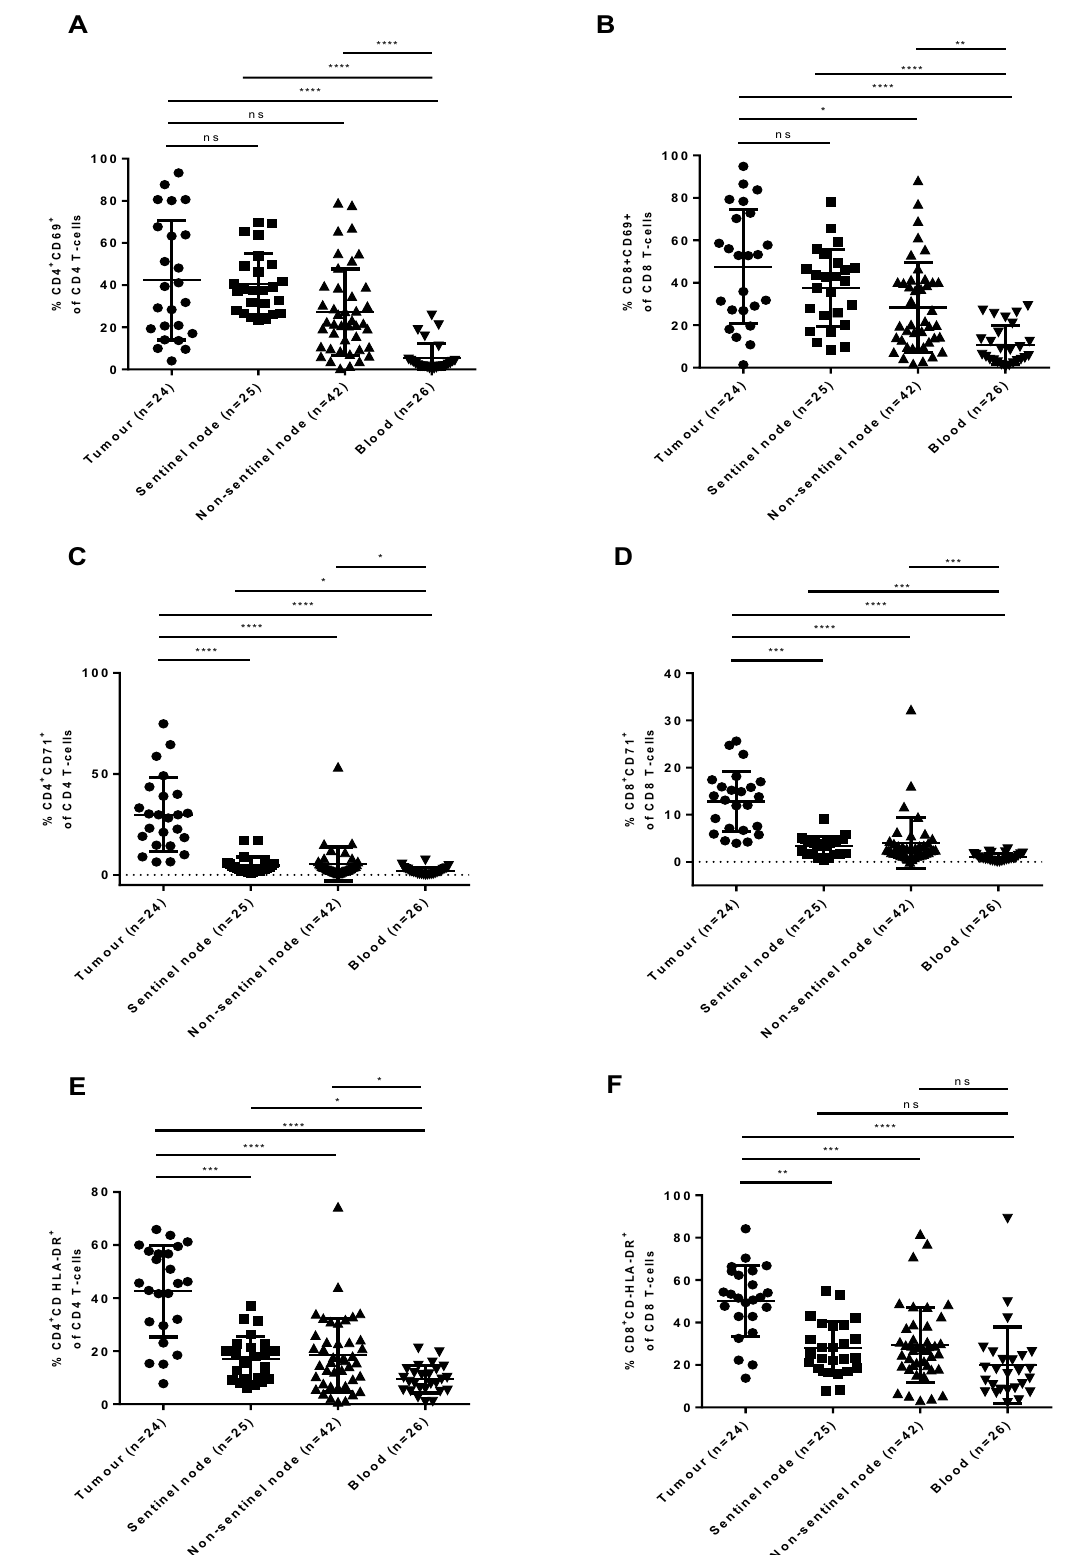
Figure 1. Single cell suspensions from OSCC tumour tissue (n = 24), sentinel node (n = 25), non-sentinel node (n = 24) and PBMC (n = 26) were analyzed by flow cytometry regarding T cell activation surface antigens. Percentages of CD69+ ( A , B ), CD71+ ( C , D ), HLA-DR + ( E , F ) CD4+ and CD8+ differ significantly between analyzed compartments. Mean with SD is represented by solid line and bars within the graph. Kruskal–Wallis test was used to compare groups. *< 0.05, **< 0.01, ***< 0.001, ****<